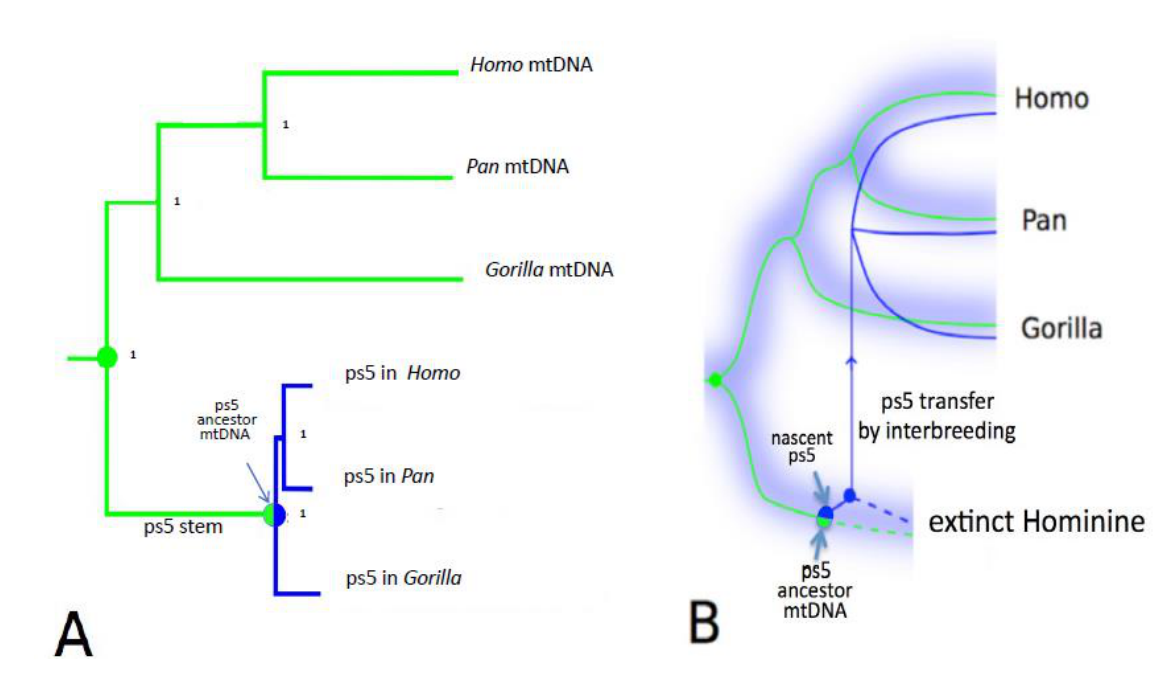
Figure 1. A joint phylogenetic tree of the hominine mtDNA and the ps5 pseudogene of mtDNA. ( A ) Green and blue lines depict the mitochondrial and the pseudogene lineages, respectively, diverging from their mitochondrial common ancestor (green circle). The common pseudogene stem (“Ps5 stem”) is colored green because, remarkably, mutations of the “ps5 stem” are mostly synonymous changes that must have occurred in a functional mitochondrial genome. This contrasts with a low fraction of synonymous changes in the pseudogene branches (blue). Note that the pseudogene branches are short because of the low mutation rates in nuclear DNA compared to mtDNA). The length of the “ps5 stem” implies ~4.5 My of evolution. The intriguing question is how did ps5 get back into the Homo-Pan-Gorilla clade after its precursor had been diverging from this clade for millions of years. Orangutan, gibbon, and baboon outgroups were omitted for simplicity (see Supplementary Notes SN2, SN4 and Figure S3 for tree building approach and stability analysis). ( B ) Interpretation of the mtDNA/ps5 tree of Figure 1A. Blue hazy branches represent species, rather than individual loci, and blue haze schematically symbolizes the superposition of the phylogenetic trajectories of all the nuclear genetic loci. Because the ps5 stem branch is essentially mitochondrial, it must have been evolving within a continuous maternal lineage, which, to accommodate the very long ps5 stem, should have been diverging for ~4.5 My. The long separation period implies that this maternal lineage was a part of a separate species. That species should have eventually gone extinct and is thus labeled “extinct Hominine”. The ps5 pseudogene was created in the extinct Hominine (half blue/half green circle) and transferred to the Homo-Pan-Gorilla clade via interspecies hybridization (thin blue arrow). Solid lines represent lineages currently extant lineages, dotted lines—extinct